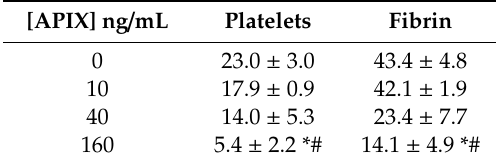
Table 1. Percentage of the covered surface at shear rate 600 s − 1.